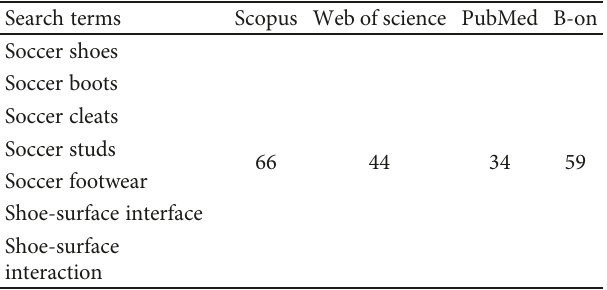
Table 2: Number of papers collected from di ff erent databases. Search